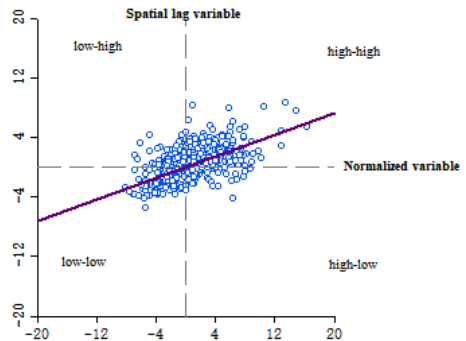
Figure . 5 Classification of bus service relative to supply and demand based on moran scatter